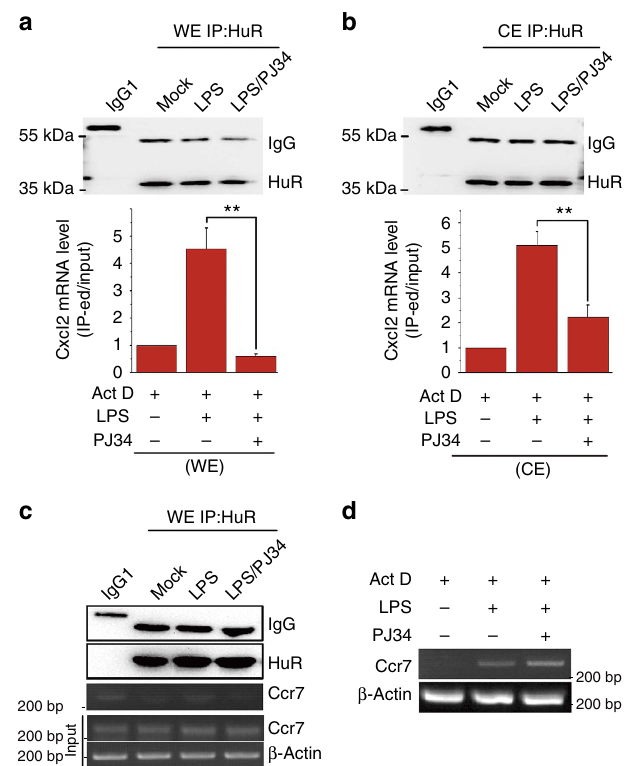
Figure 5 | Protein PARylation promotes the binding of HuR to Cxcl2 mRNA. ( a , b ) PARP1 activation is involved in the LPS-induced binding of HuR to Cxcl2 mRNA. RAW 264.7 cells were exposed to 500ngml (cid:2) 1 LPS for 1h to boost pro-inflammatory gene expression, followed by the addition of Act D. Meanwhile, the cells were withdrawn from LPS, maintained in LPS or treated with LPS þ PJ34 for another 2h. Whole-cell lysates ( a ) and cytolic extracts (CEs) ( b ) were prepared. RNA-IP was conducted using a HuR antibody. Half of the bead–antibody–protein/mRNA complexes were utilized for immunoblotting to assess equal loading/input of HuR, and the remaining half was subjected to real-time PCR to detect pull-down Cxcl2 mRNA levels using that in the whole-cell lysate for calibration. ( c ) Ccr7 mRNA is absent in the HuR-associated complex that comes from cells exposed to LPS. RAW 264.7 cells were treated differently, and an RNA-IP was conducted using a HuR antibody as described in the legend to a and b . HuR-associated Ccr7 mRNA levels were shown by PCR with reverse transcription (RT)–PCR and electrophoresis. ( d ) Ccr7 mRNA stability is not related to PARP1 activity. RAW 264.7 cells were exposed to LPS stimulation for 1h and then subjected to transcriptional inhibition with the maintenance of the LPS challenge ( ± P J34), or not, for 4h. RT–PCR and electrophoresis were conducted to detect Ccr7 mRNA levels. Data were expressed as mean ± s.d. ( n ¼ 5), and analysed by one-way analysis of variance. ** P o